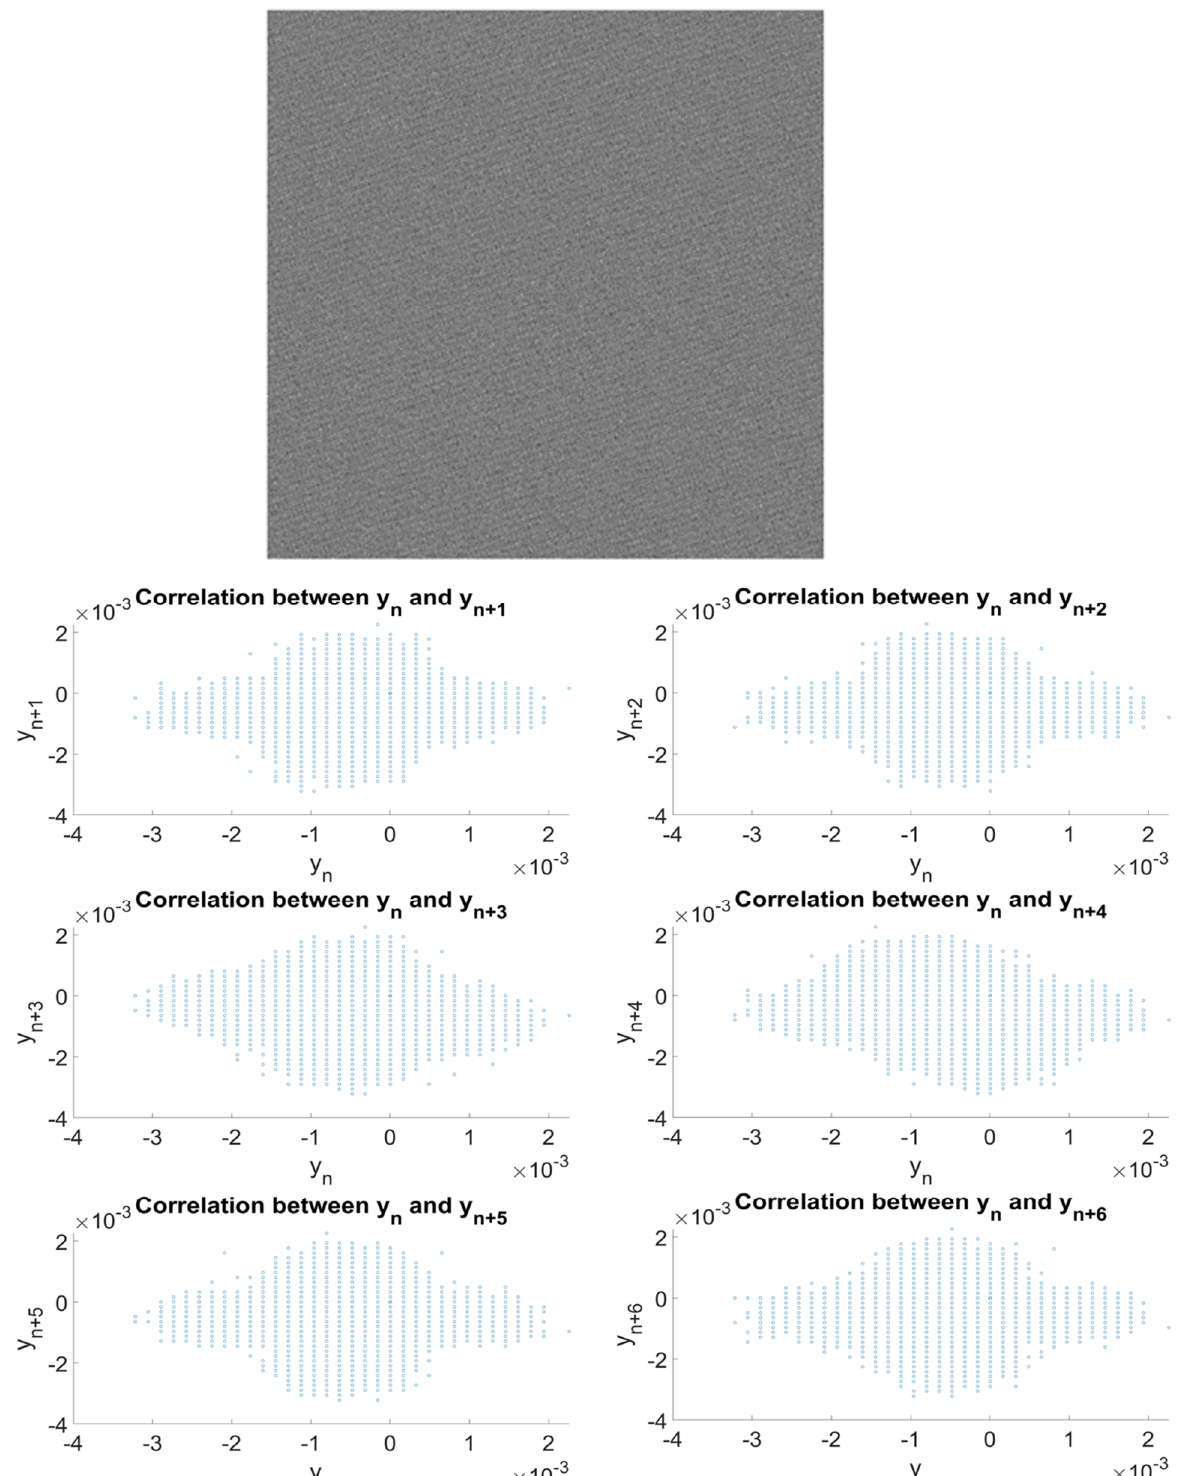
Figure 8. Scatter plots of two pixels along the fast axis. In each plot, y _ n is the value of a pixel at column n . The image was acquired with an acquisition time of 16